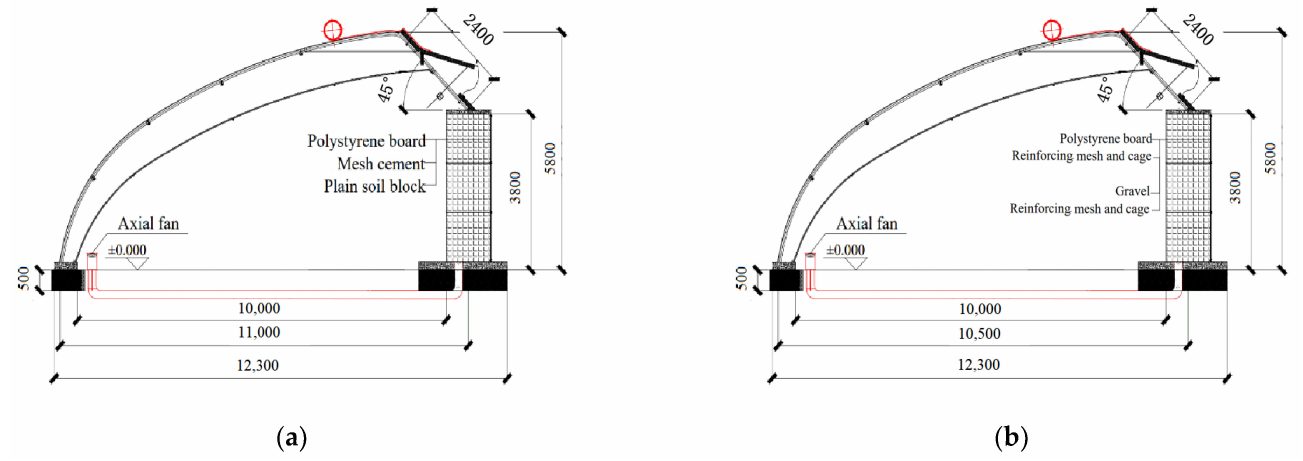
Figure 2. Solar greenhouse structure site map. ( a ) Soil module solar greenhouse (SG). ( b ) Pebble module solar greenhouse (PG).